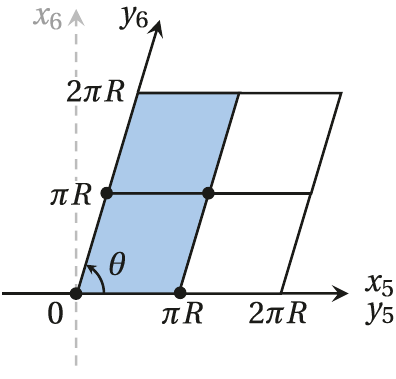
Figure 1 . The fundamental domain of the orbifold T 2 /Z 2 is shown. The shaded region is a fundamental region and the black dots represent the four fixed points of the orbifold. This figure is drawn for a generic complex structure τ cos θ Re τ/ τ ≡ | |